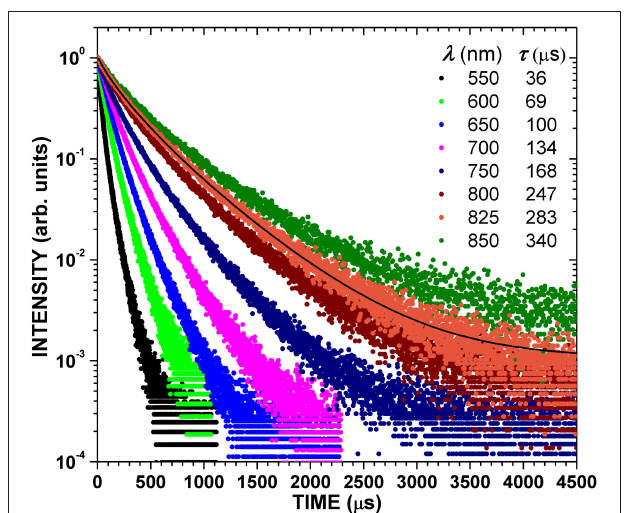
FIGURE 4 | Time-resolved PL of HWA-treated SiNCs at indicated wavelengths. Indicated lifetimes correspond to the time taken for the PL to fall by a factor of e . The black solid curve is a fit with a stretched